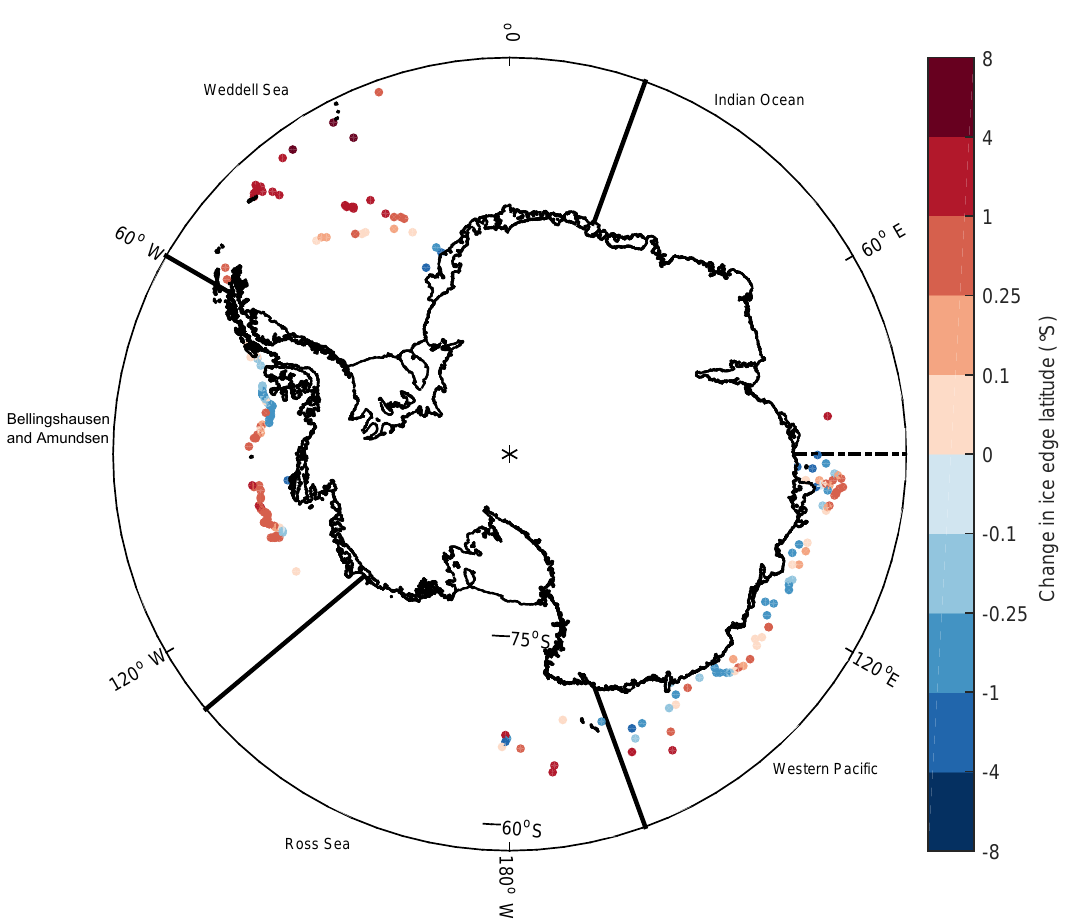
Figure 2. Anomaly between ship-observed ice edge and the 1989–2014 mean PM Bootstrap algorithm derived ice edge position for the appropriate calendar day. Anomalies are plotted at logbook